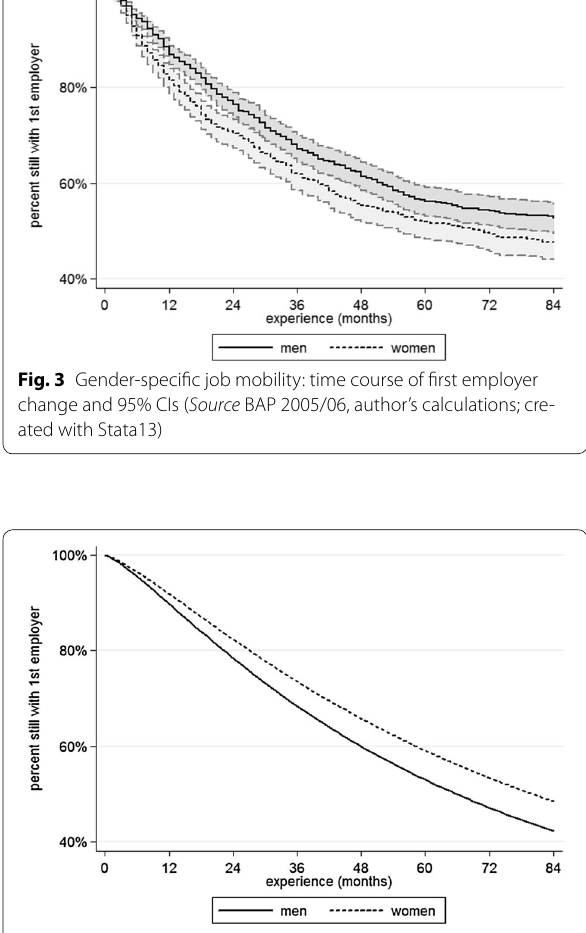
Fig. 4 Gender-specific job mobility: time course of first employer change ( Source BAP 2005/06, author’s calculations, control variables included; created with